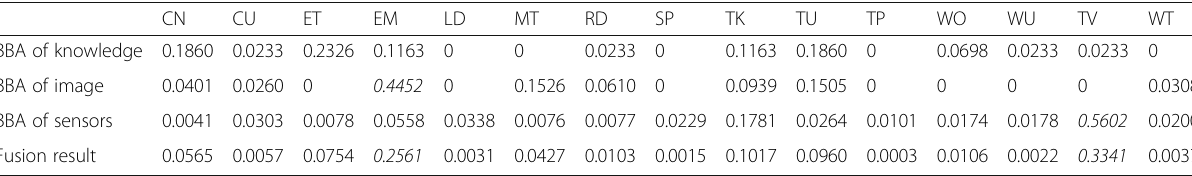
Table 6 Example of three-source fusion using the PCR6 rule CN